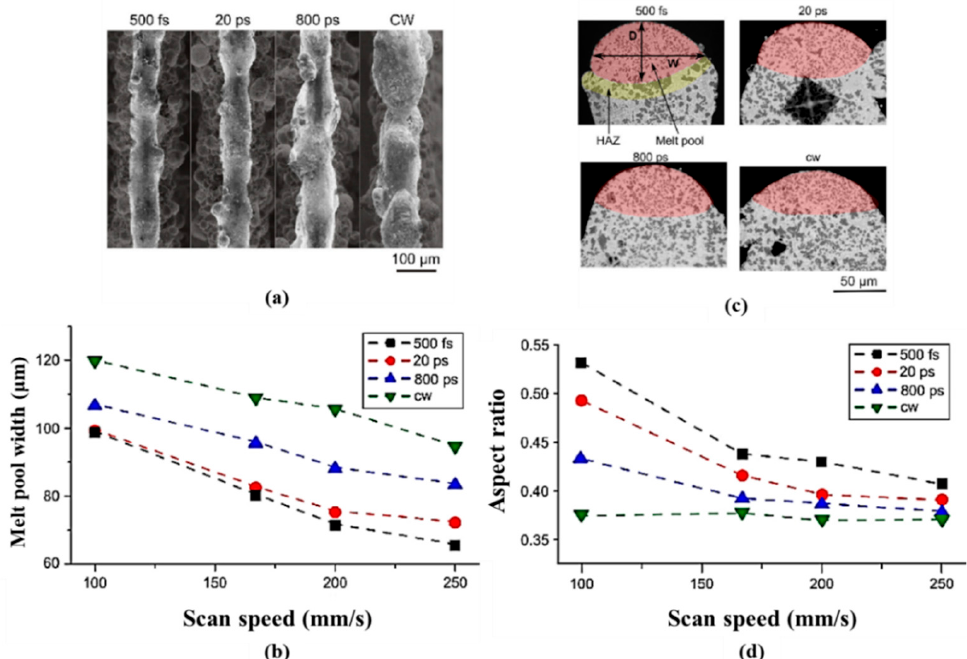
Figure 28. ( a ) SEM images of the walls (top view) above the parameters and a layer thickness of 15 microns; ( b ) scan speed versus melt pool width for different lasers; ( c ) melt pool width at the tip of the wall captured by optical microscopy; ( d ) scan speed versus aspect ratio between melt pool depth and width (increases for shorter pulse duration) (Adapted from reference [183]).